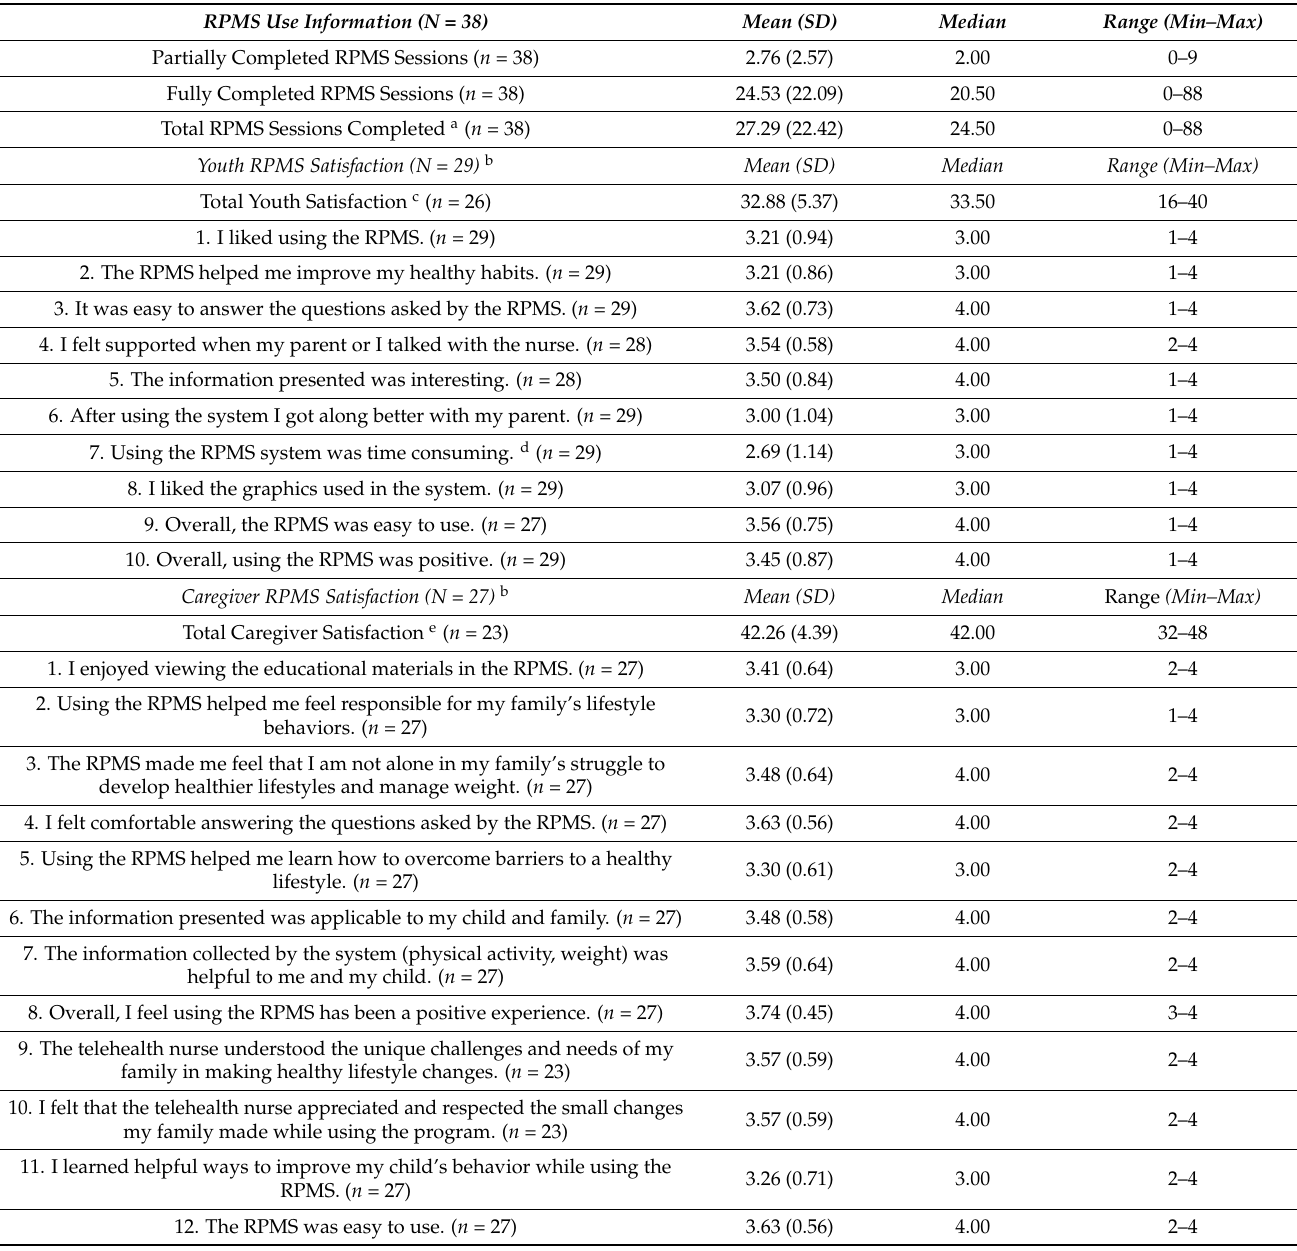
Table 2. RPMS Use and Satisfaction